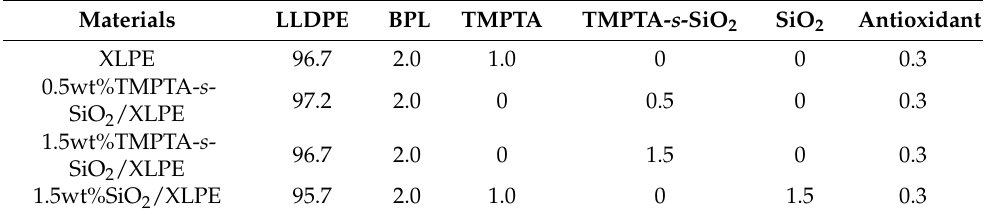
Table 1. Blending components (wt%) for preparing XLPE